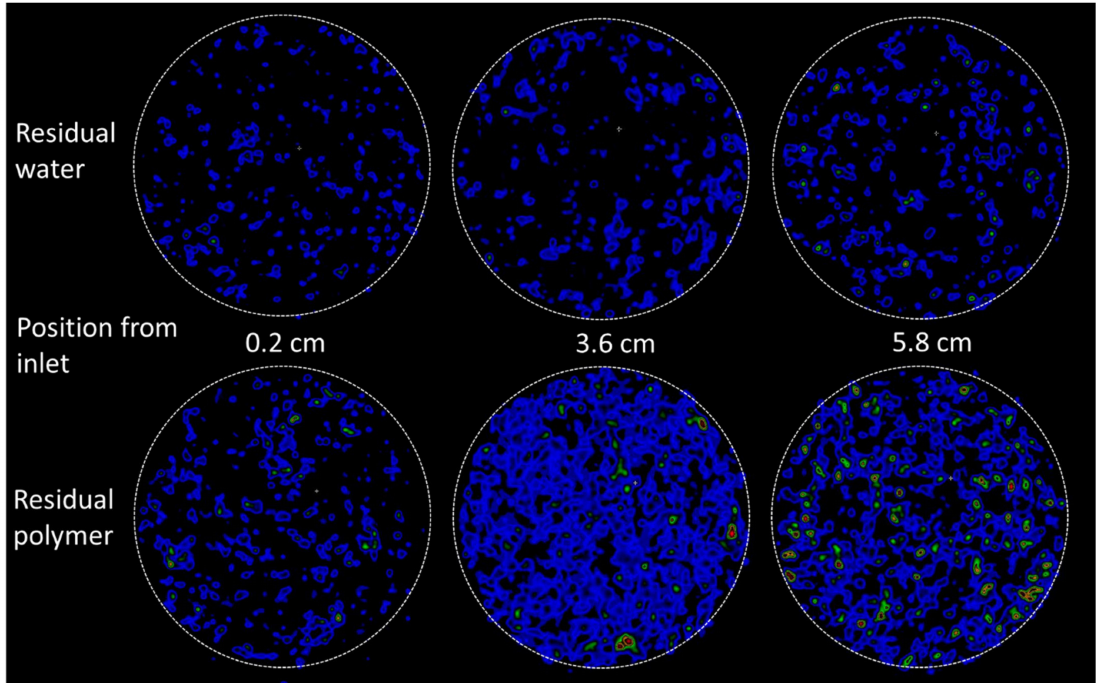
Figure 15. PET images of the core cross section comparing residual water ( top ) to residual polymer ( bottom ) in the core after long-term oil flooding. The images are corrected for radioactive decay and produced using the same threshold settings. The signal to noise ratio was 32.8 (water) and 34.4 (polymer) at this stage of injection. The rendered PET signal in the images should not be understood as quantitative saturation, but rather serve as a basis for comparison of residual fluids in oil flooded cores containing radioactive water versus radioactive polymer. Blue color indicates the presence of radioactivity (i.e., labelled aqueous phase), warmer colors indicate a higher concentration of aqueous